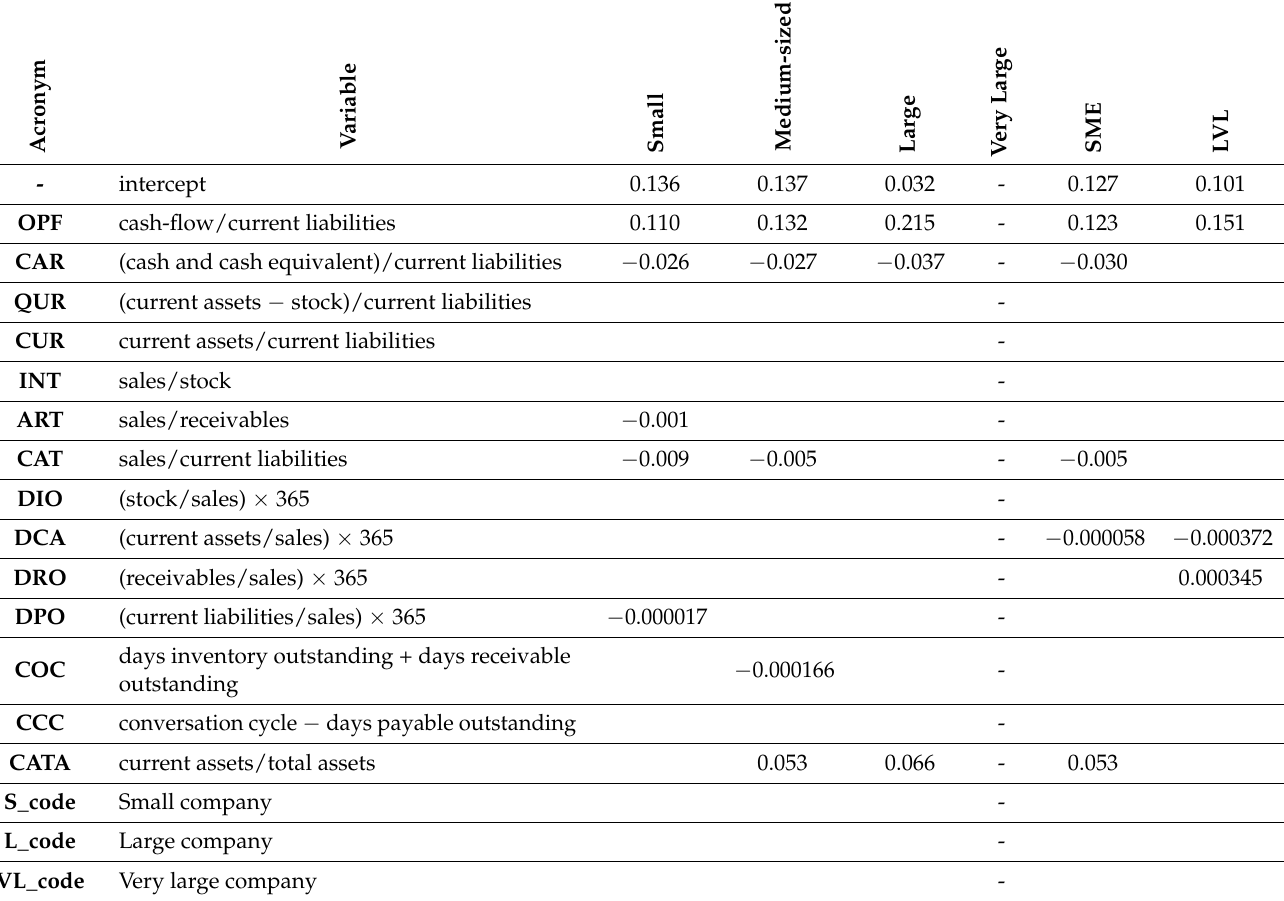
Table 10. Coefficients in models for the transport companies in the Slovak